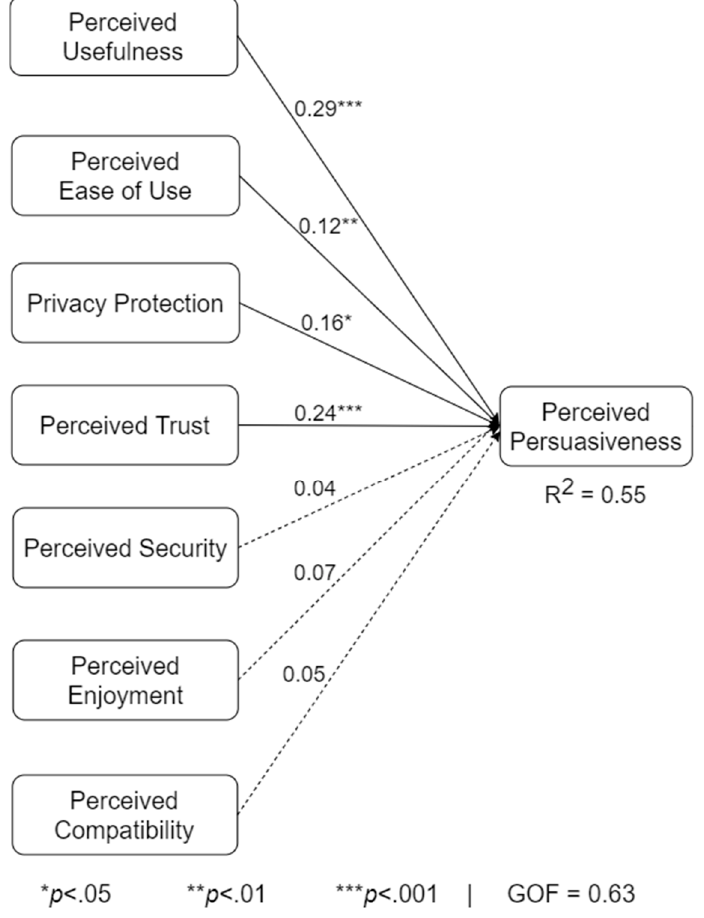
Figure 5. Overall model for the entire